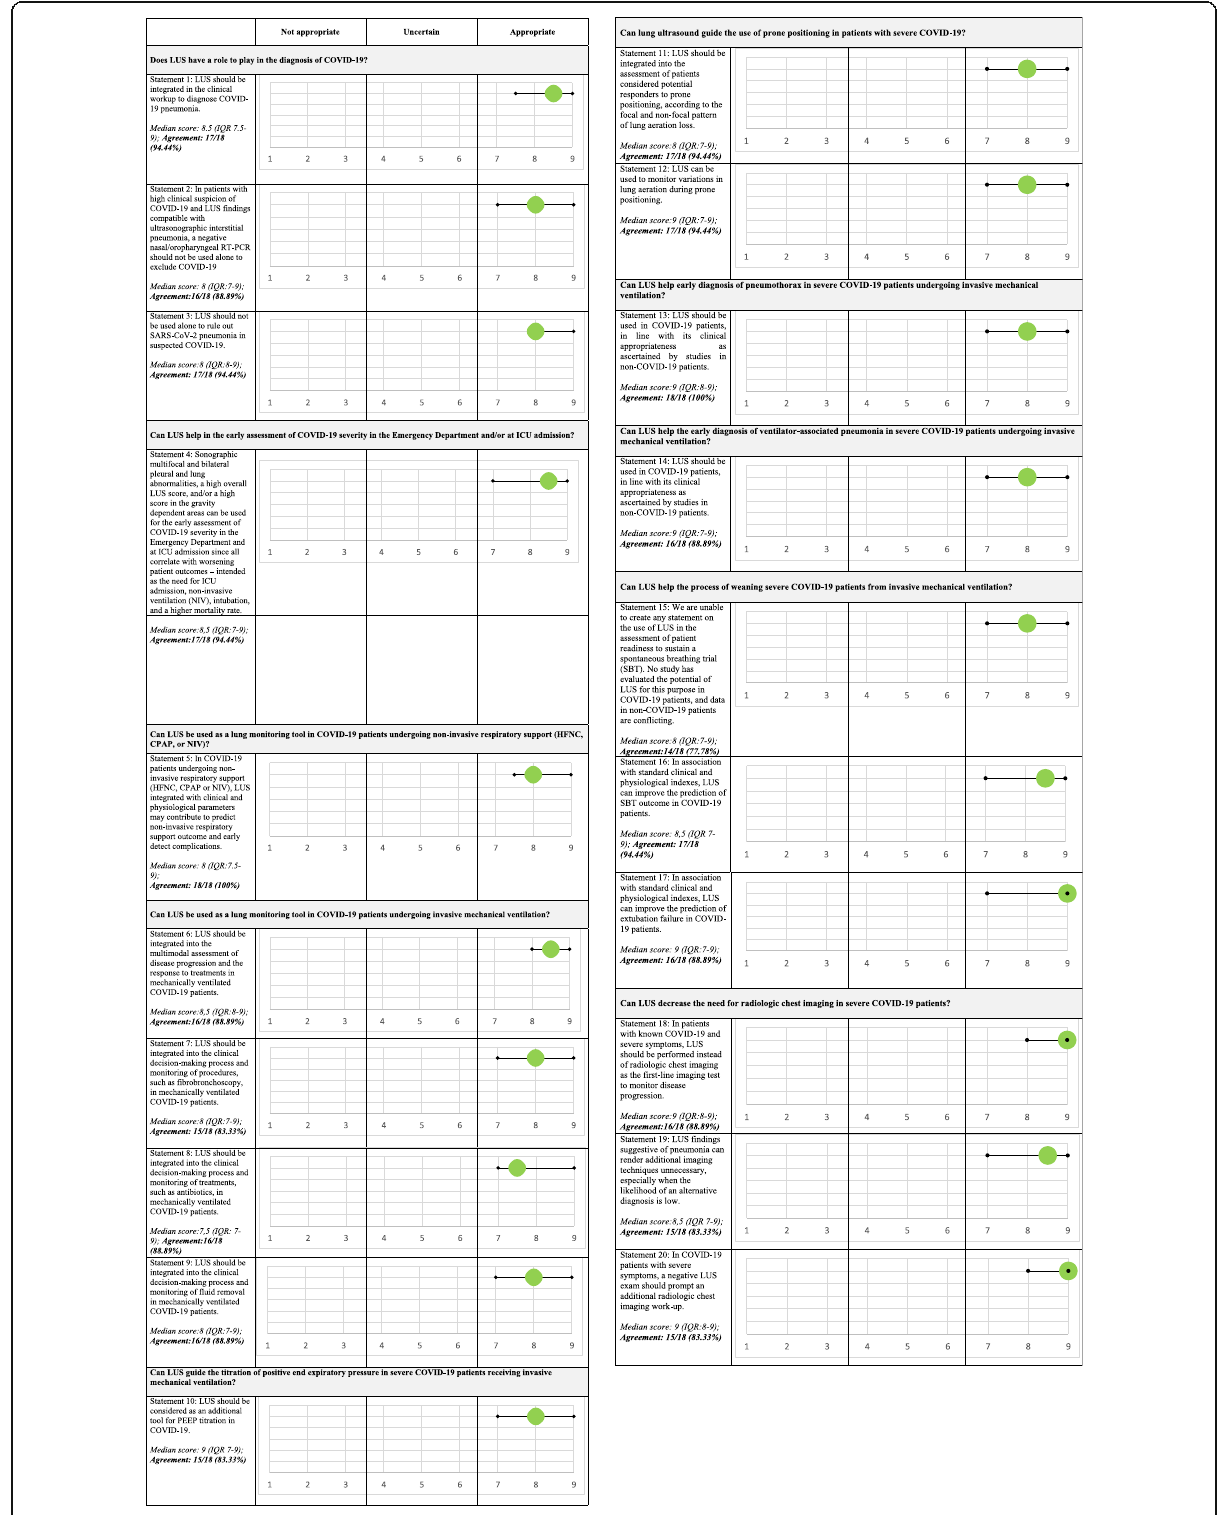
Fig. 1 The median score (plus interquartile range) and agreement percentage for all the statements contained in the final consensus